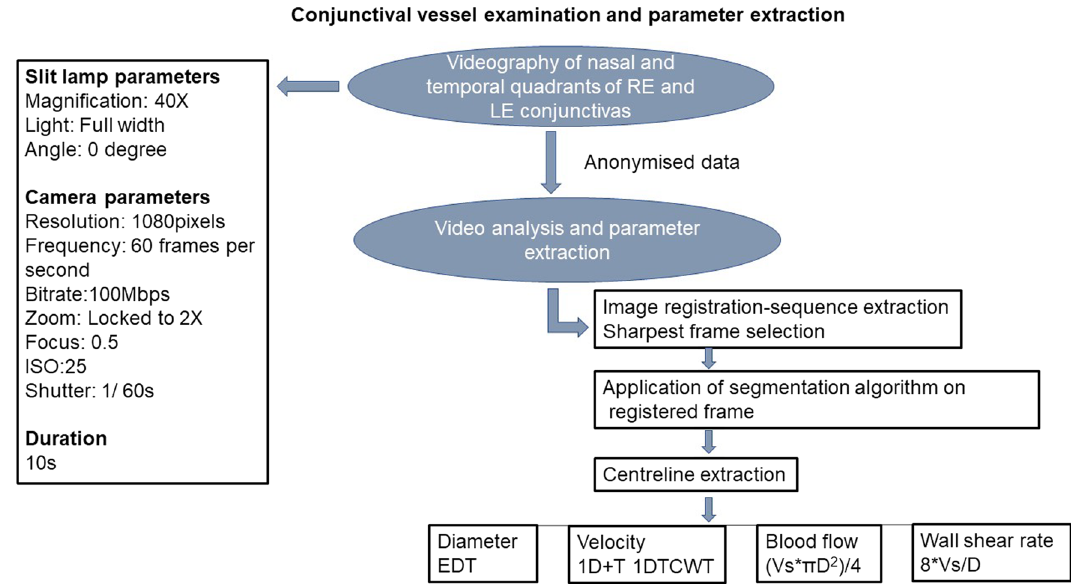
Figure 1. Vessel parameter data collection. RE Right Eye, LE Left Eye, EDT Euclidean Distance Transform, 1D + T 1 Dimension + Time, CWT Continuous Wavelet Transform, Vs Cross Sectional Velocity, D